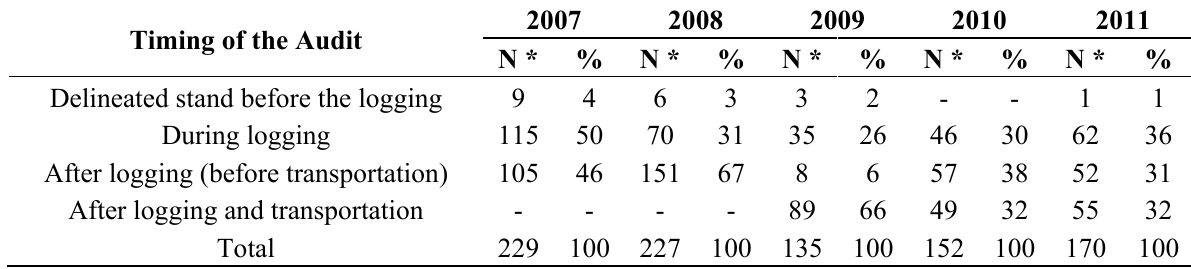
Table 6. Number and timing of field audits of the company’s suppliers.